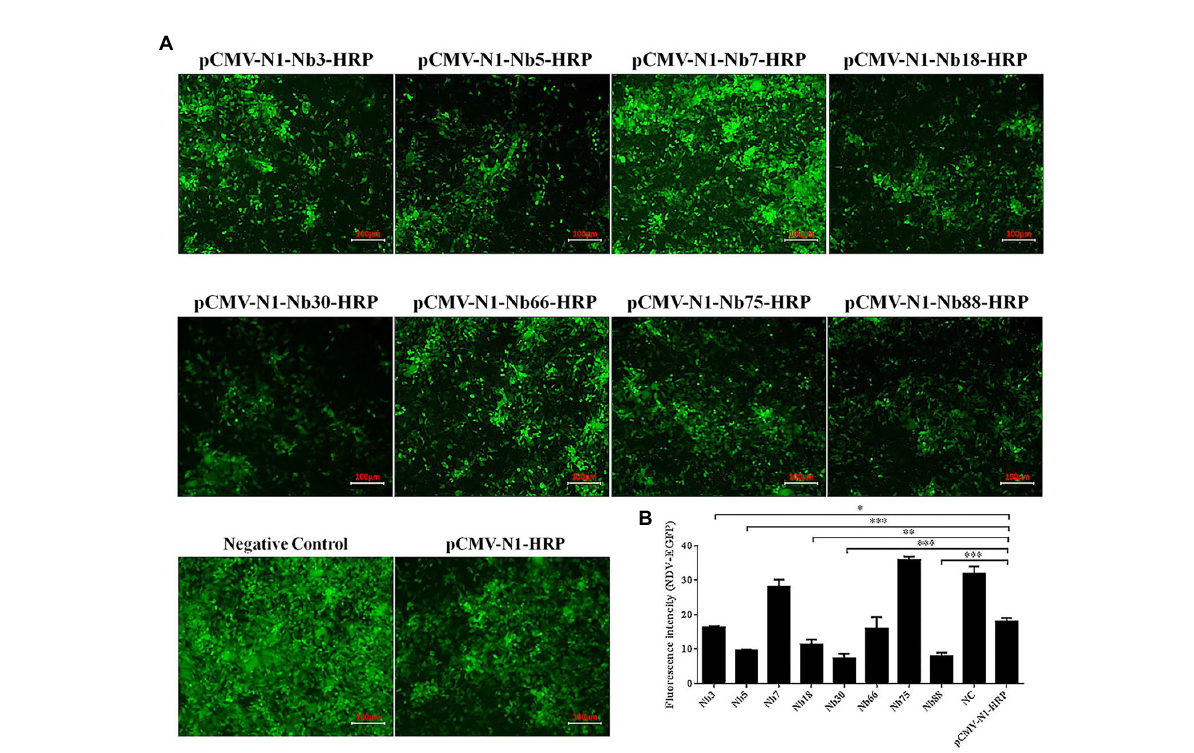
FIGURE 3 Preliminary analysis of intracellular expressing nanobodies against NDV NP proteins inhibiting replication of the recombinant NDV-GFP strain in DF1 cells. (A) Results of the intracellular GFP experiments in DF-1 cells infected with recombinant NDV-GFP strain. (B) Fluorescence intensity of the NDV-GFP was shown. The results were performed in triplicate and data are presented as the mean ± SD. * p < 0.05; ** p < 0.01; *** p < 0.005 (two-tailed Student’s t